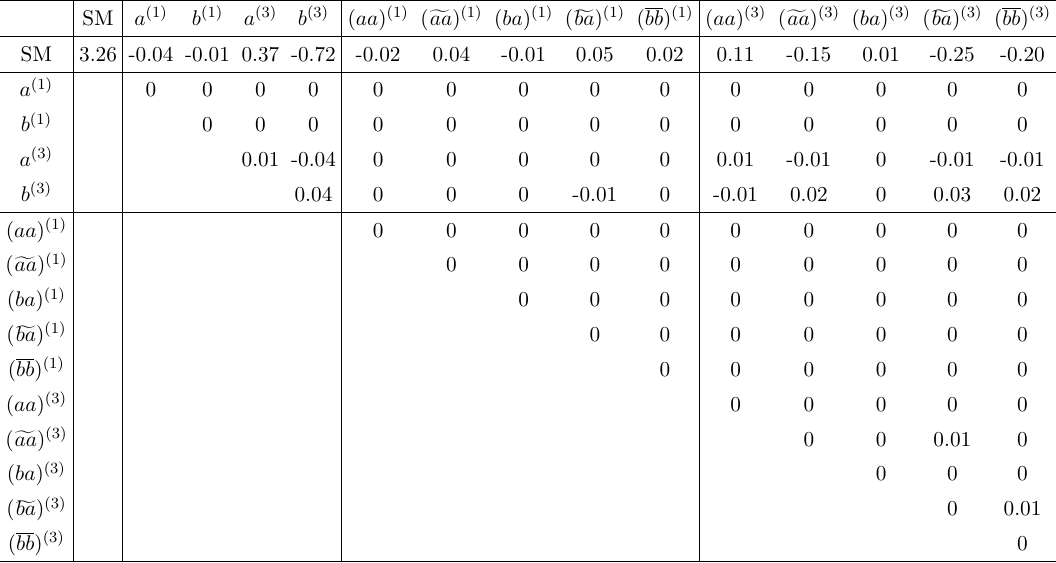
Table 2 . Contributions of flavor coefficients to B ( µ 0 = 2 . 4 TeV ; the cutoff scale is fixed to Λ = 1 TeV. The contributions are rounded to two decimal